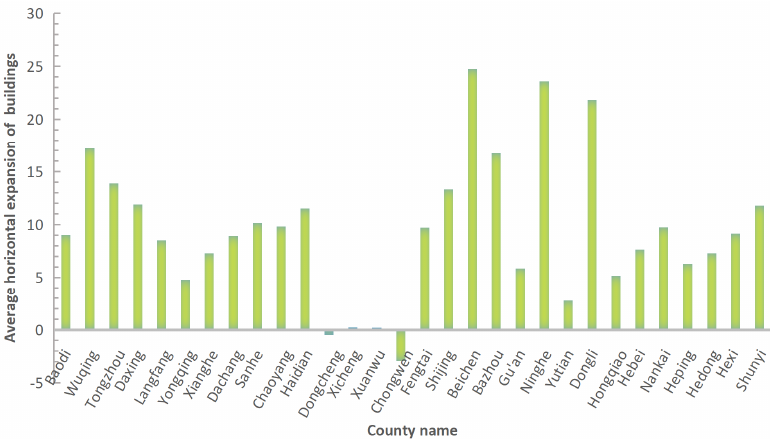
Figure 11. Comparison of building horizontal expansion between counties. Note: The average horizontal expansion of buildings in Figure 11 expresses the expansion ratio of construction land per unit area, which is dimensionless.